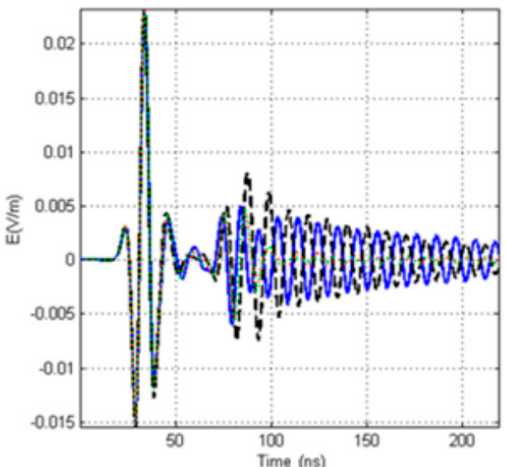
Figure 9. The received signal when the dielectric constant of the borehole fluid is 81. (blue: the east antenna; black: the west antenna; red: the south antenna, green: the north antenna).